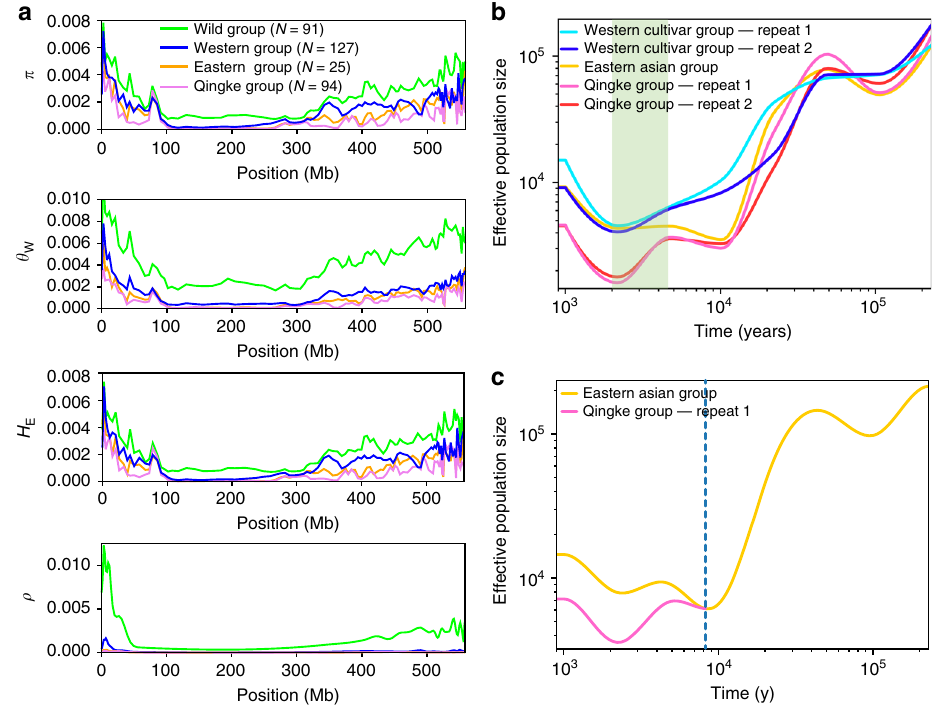
Fig. 4 Founder effect event of qingke. a Genome-wide genetic diversity in chromosome 1H in barley groups. Values of unbiased nucleotide diversity ( π ), Watterson ’ s estimator ( θ W ), gene diversity/heterozygosity ( H E ), and recombination rate ( ρ ) were plotted with “ smooth bezier ” treatment of Gnuplot (http://www.gnuplot.info/). Values on the other chromosomes (2H – 7H) are presented in Supplementary Figures 4 – 7. Qingke showed lower genome-wide genetic diversity compared to other barley groups. b Effective population size inferred by SMC ++ 66 based on WGS SNPs data for qingke, western cultivar, and eastern Asian groups. The SMC ++ run was repeated two times with seven randomly chosen accessions of qingke and western cultivar groups, respectively. A marked decline of effective population size of qingke compared with eastern Asian group from ~2000 to ~4500 years ago is highlighted in green. c Split time when qingke and the eastern Asian landrace separated from their ancestry inferred by SMC ++ 66 . The dash line indicates the split time was nearly 8000 years ago. Source data are provided as a Source Data fi le